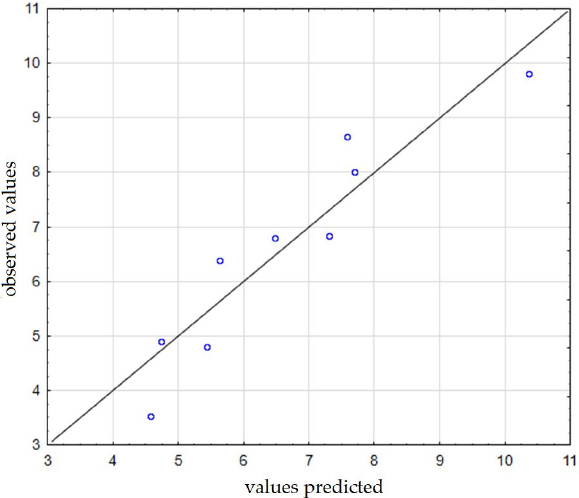
Figure 7. Presentation of the observed values in relation to those predicted for D 32 .